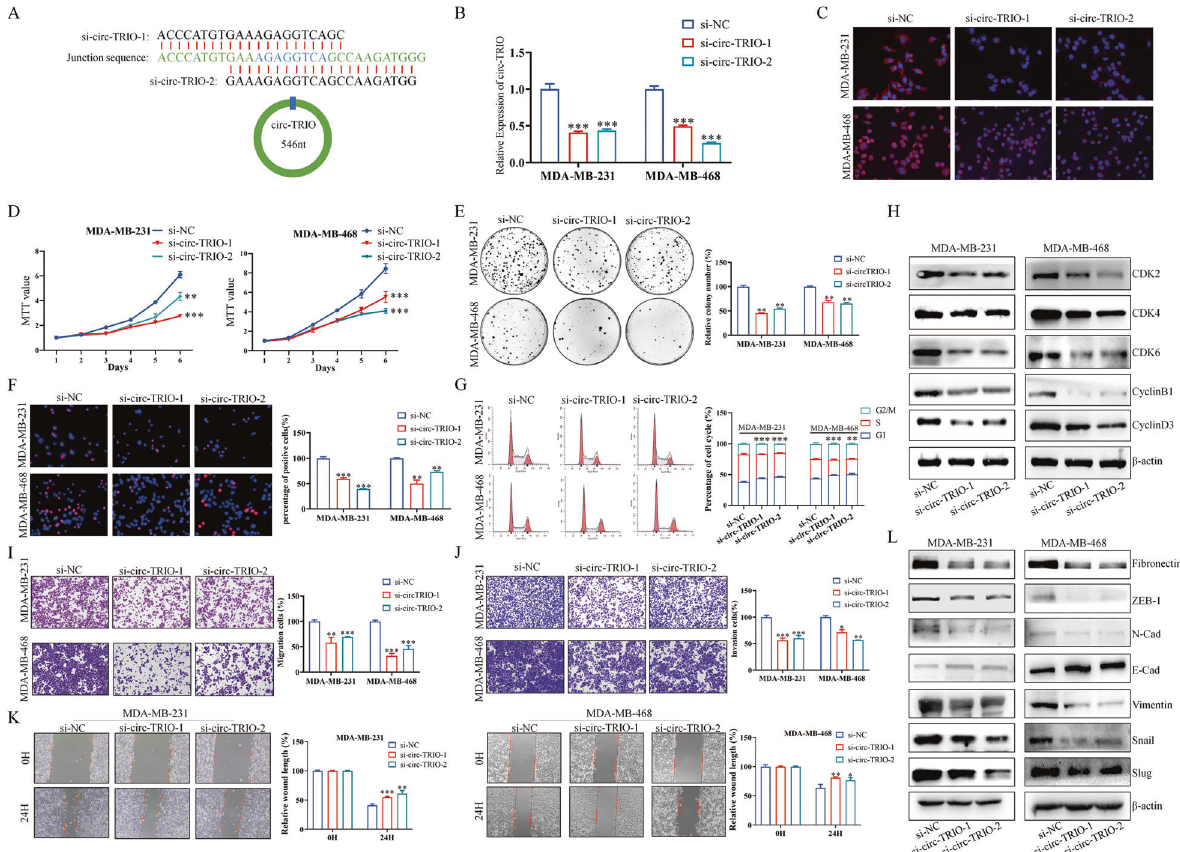
Fig. 2 Knockdown of circ-TRIO suppresses the proliferation, migration, and invasion of TNBC cells. A Schematic illustration showing the sequences of the siRNAs targeting the back-splicing junction sequence of circ-TRIO. B qRT ‒ PCR was used to examine the inhibition ef fi ciency of the siRNAs. C Fish assay revealed the inhibition ef fi ciency of the siRNAs. MTT ( D ) and colony formation assays ( E ) were used to assess the proliferation rate of TNBC cells after the knockdown of circ-TRIO. EdU ( F ) and fl ow cytometry ( G ) assays were performed to evaluate the effects of circ-TRIO inhibition on the proliferation activity of breast cancer cells. H The expression of representative cell cycle-related proteins was revealed by Western blot assays. The migration ( I ) and invasion ( J ) abilities of the MDA-MB-231 and MDA-MB-468 cell lines after the knockdown of circ-TRIO were evaluated by using Transwell assays. K Wound-healing assays were performed to identify the migration ability. L Western blot assays were performed to evaluate the expression changes of EMT pathway-related proteins after circ-TRIO knockdown. * p < 0.05; ** p < 0.01; *** p <